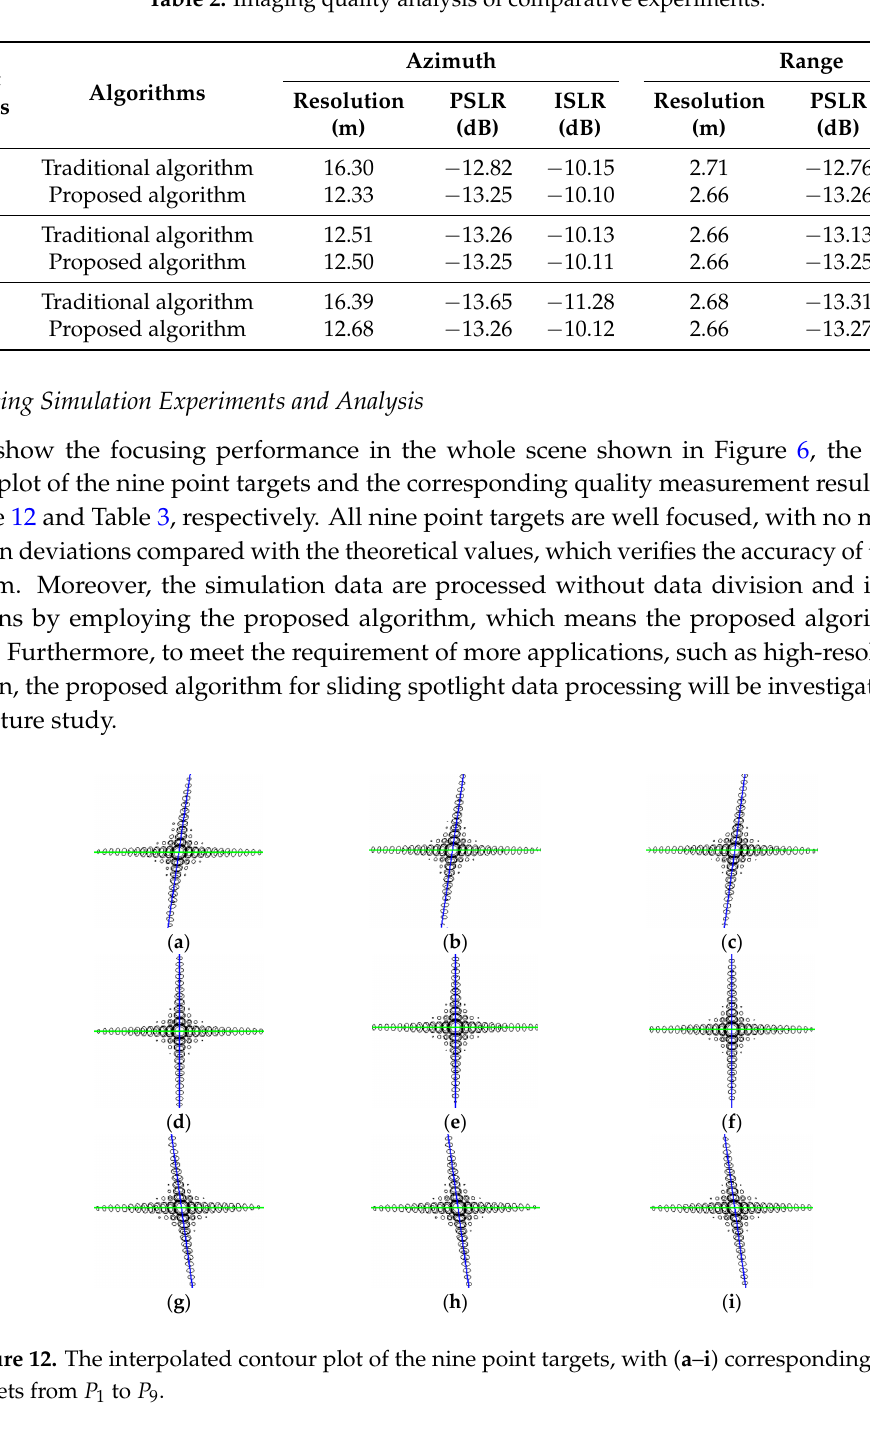
Table 2. Imaging quality analysis of comparative experiments.